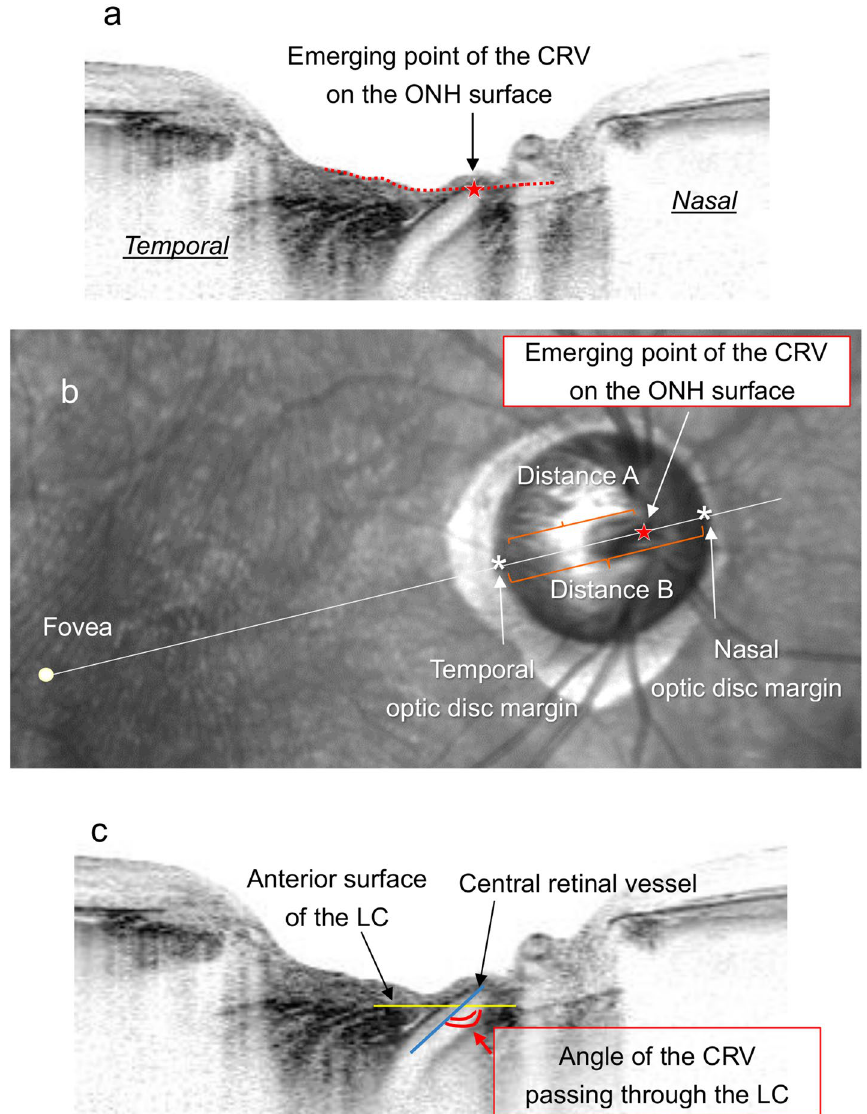
Figure 2. Assessment of the optic nerve head (ONH) parameters. ( a ) Identification of the point of central retinal vessel (CRV) emergence onto the ONH surface by using a B-scan that captured the path of the CRV through the LC. The surface of the ONH is traced by the red dashed line, and the point at which the CRV emerged is presented as a red star. ( b ) Assessment of the position of the CRV on the ONH as the point where the CRV emerged on the ONH surface. The point identified in the B-scan in ( a ) was plotted on the corresponding location on the infrared fundus image (red star). The distance between the temporal optic disc margin and the point of CRV emergence onto the ONH surface was measured on the line connecting the fovea and the emerging point (Distance A). Then, the distance between both sides of the optic disc margin was measured on the same line (Distance B). The position of the CRV on the ONH surface was assessed as a percentage of Distance A to Distance B [(Distance A/ Distance B) × 100]. ( c ) Assessment of the angle of the CRV passing through the LC. It was assessed as an angle between the anterior surface of the LC (yellow line) and the line penetrating the center of the CRV (blue